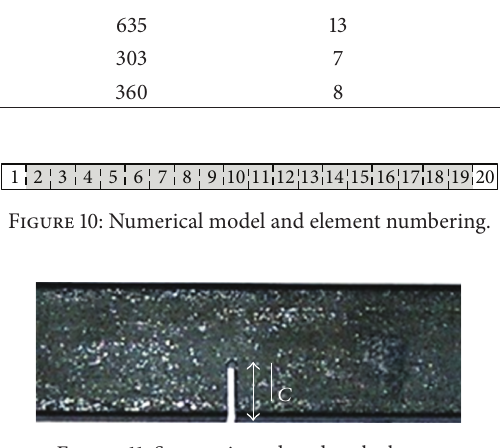
Figure 11: Saw cut introduced to the beam.